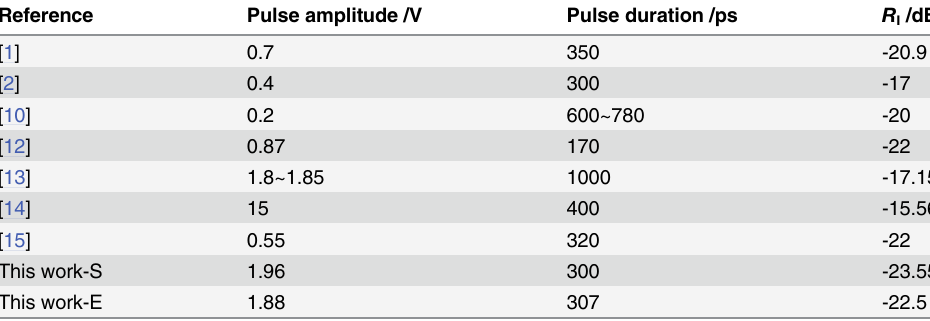
Table 2. Comparisons with pulse generations in